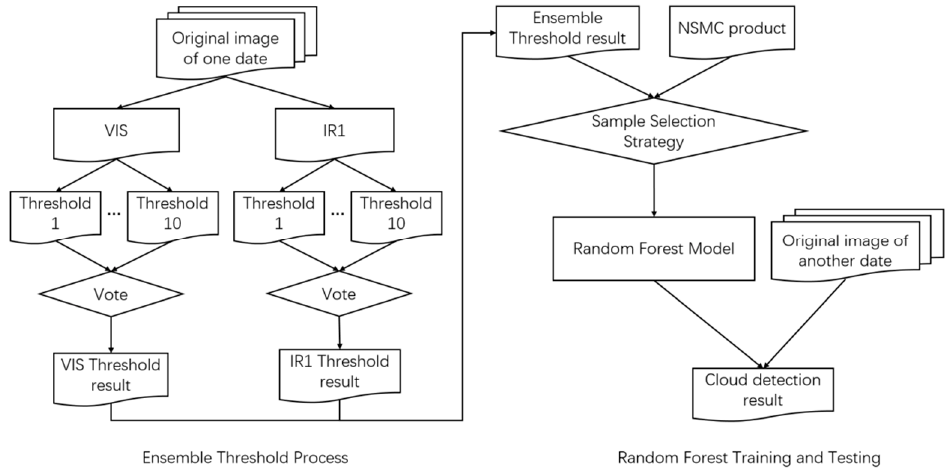
Figure 4. Algorithm flowchart.